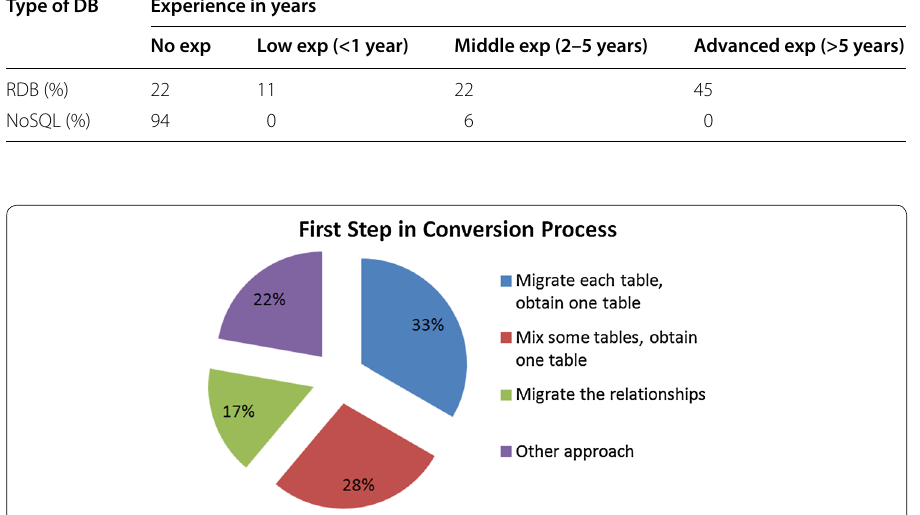
Fig. 3 First step in the conversion